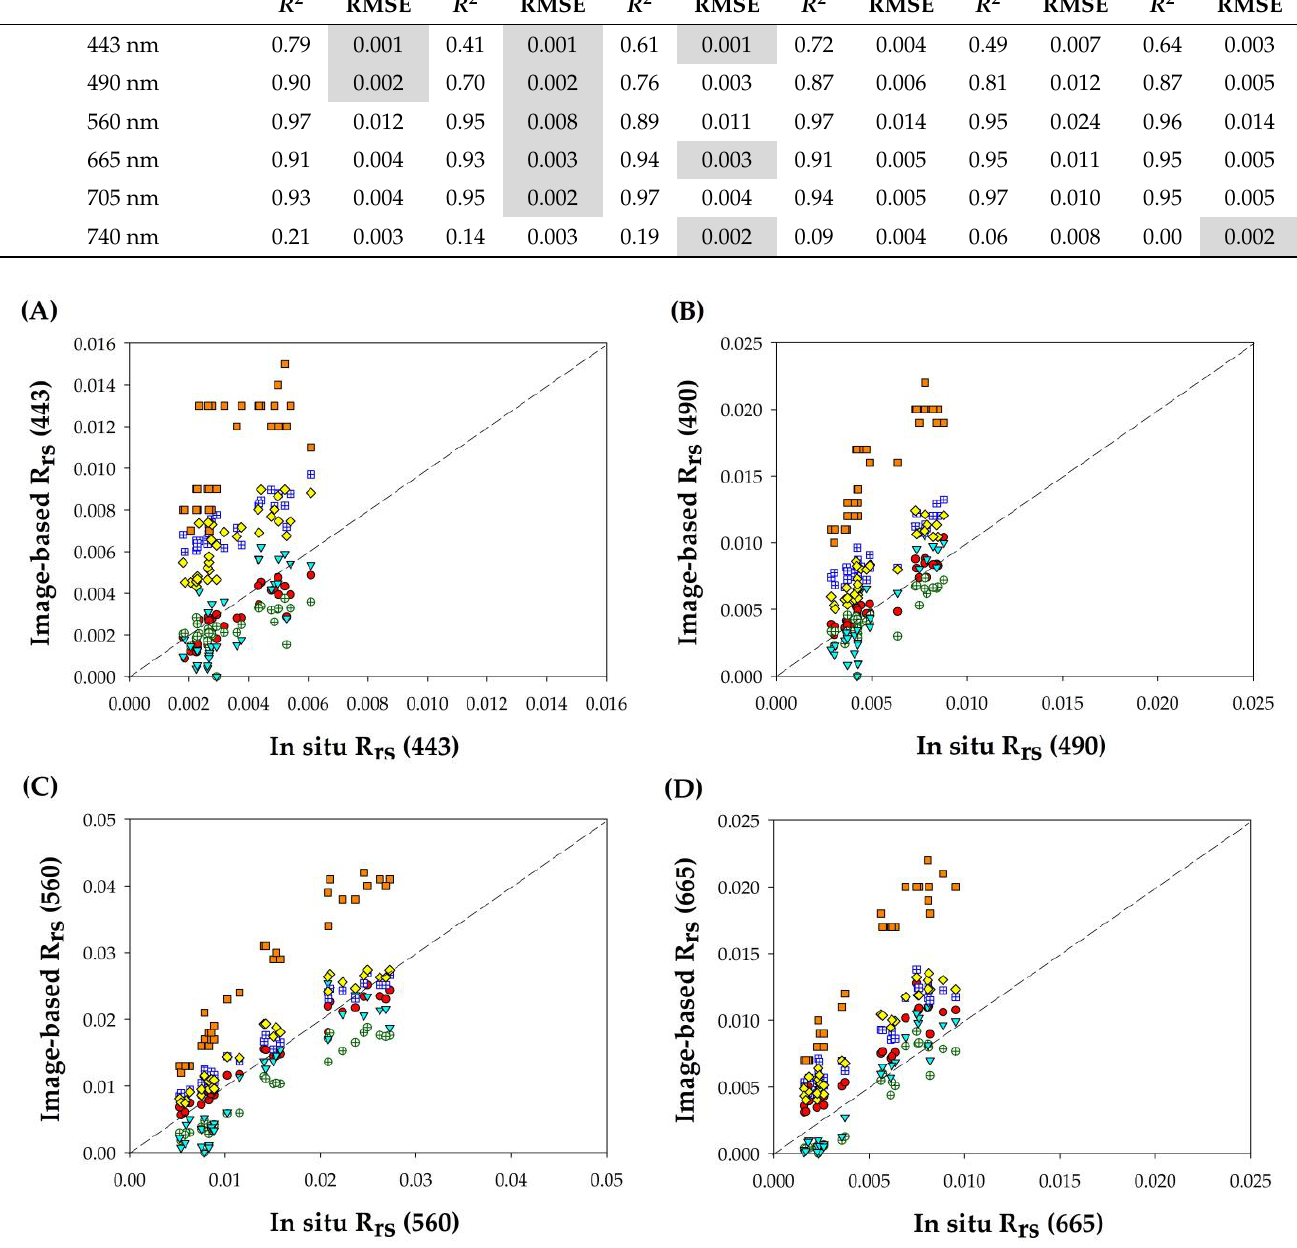
Figure 4. Performance assessment of the atmospheric correction routines (ACOLITE, C2RCC, C2X, iCOR, MAIN and Sen2Cor) for the Sentinel-2/MSI spectral bands. ( A ) Band 1 (443 nm), ( B ) Band 2 (490 nm), ( C ) Band 3 (560 nm), ( D ) Band 4 (665 nm), ( E ) Band 5 (705 nm) and ( F ) Band 6 (740 nm)